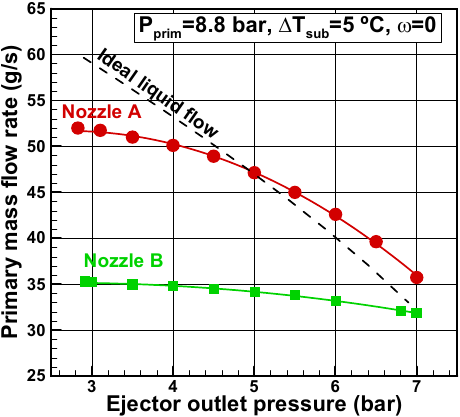
Figure 5. Effects of the nozzle’s divergent section on the critical mass flow rate. Figure 5. E ff ects of the nozzle’s divergent section on the critical mass flow